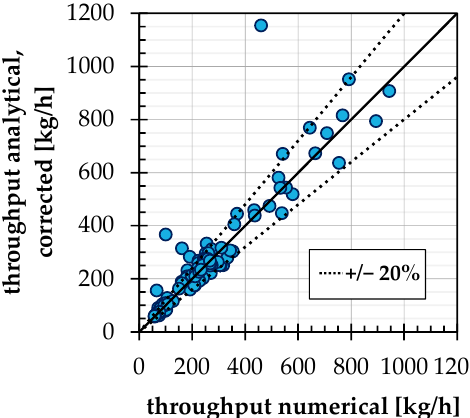
Figure 12. Comparison of numerical throughput with analytical calculation (with the use of the correction factor for case 2a) for all test points of DoE.